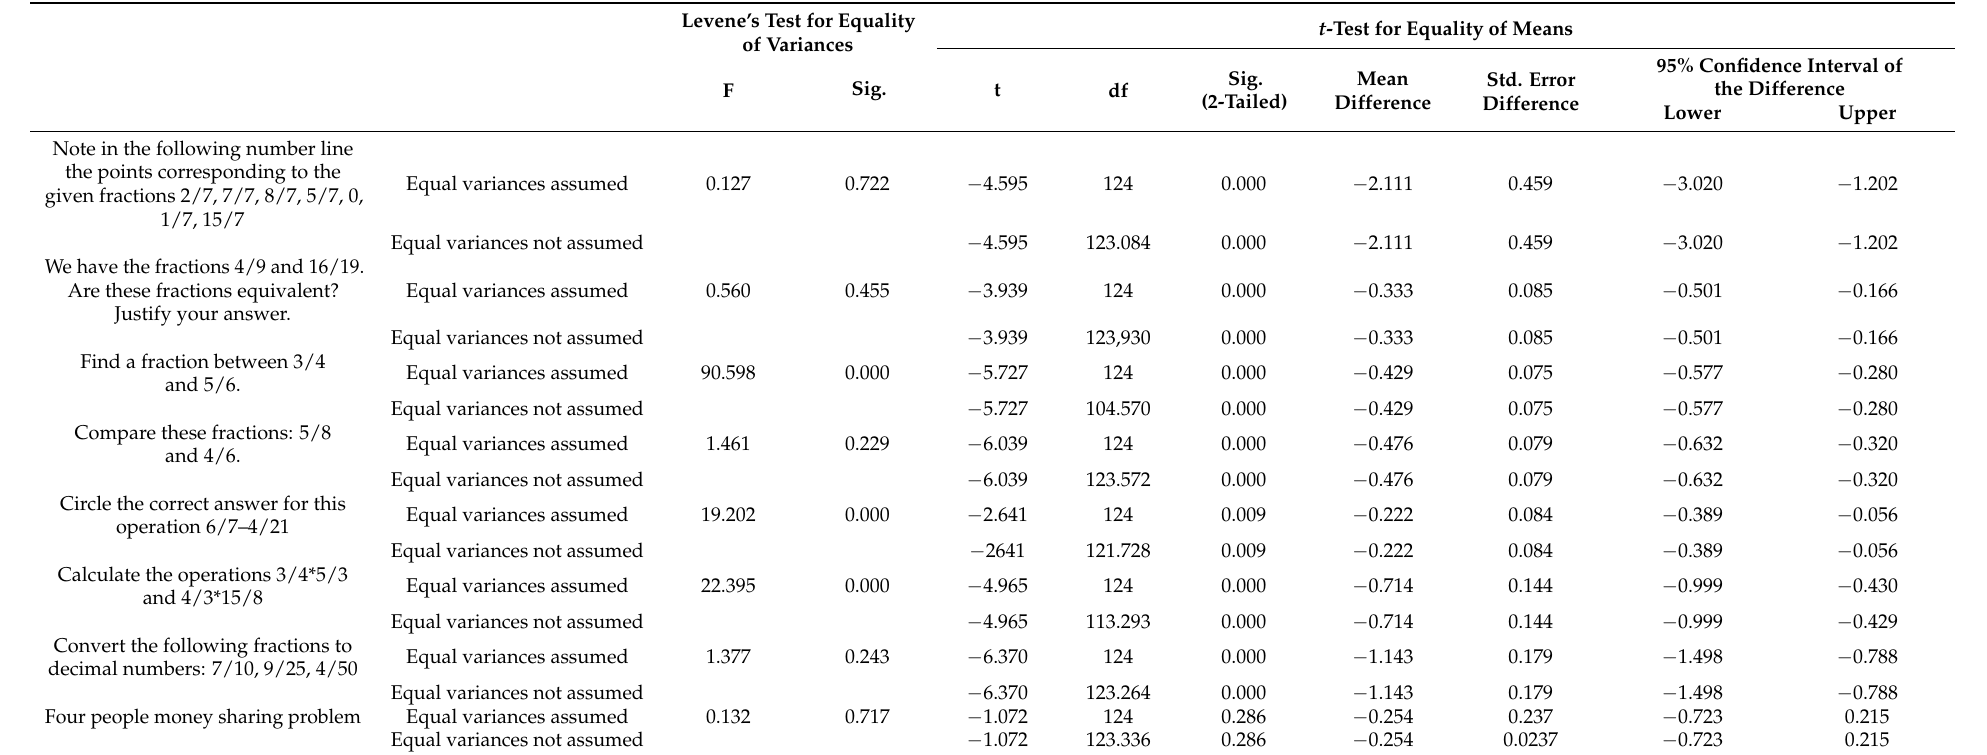
Table 5. Independent Samples